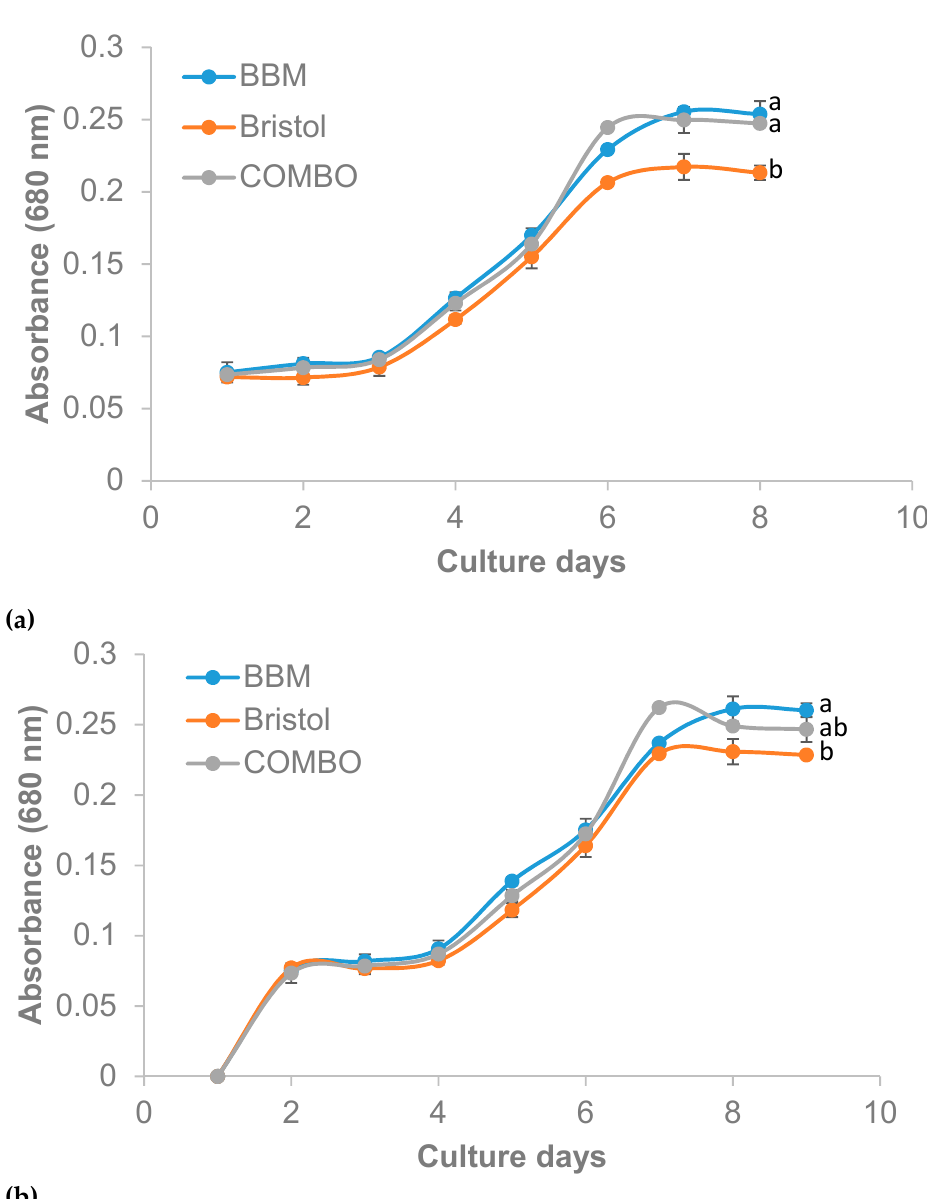
Figure 3. Optical density of Ankistrodesmus falcatus in 100% ( a ) and 50% ( b ) concentration (means ± standard errors). Line with different lowercase letters differs significantly ( p ≤ 0.05).